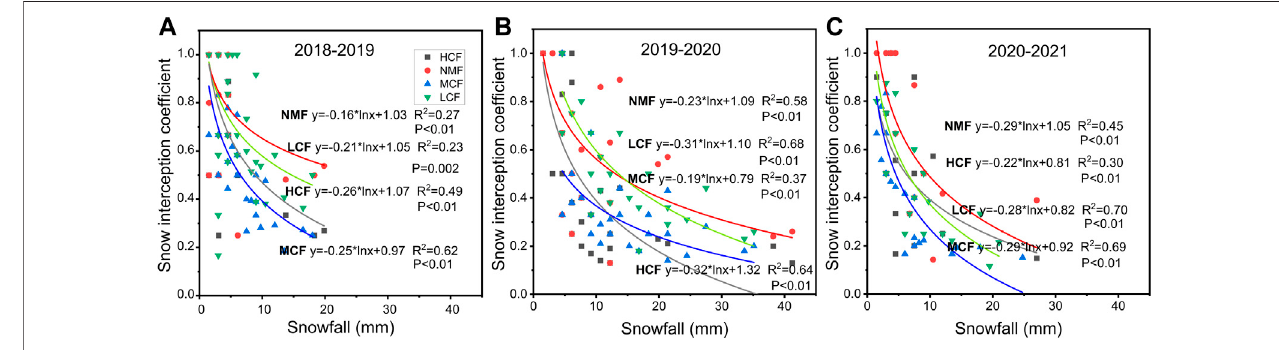
FIGURE 7 | Relationship between the forest canopy interception coef fi cient ( C IE ) and snowfall for each ofthe three years, (A) 2018 – 2019, (B) 2019 – 2020, and (C) 2020 – 2021. The different icons indicate different forest types. One dot is for one snowfall event. The fi tted curves are logarithmic functions of the snowfall.